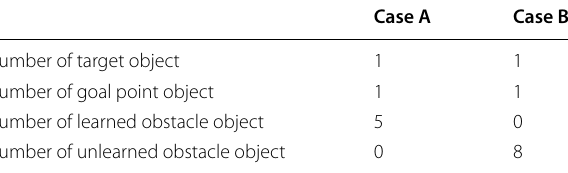
Table 10 Environmental conditions for each case